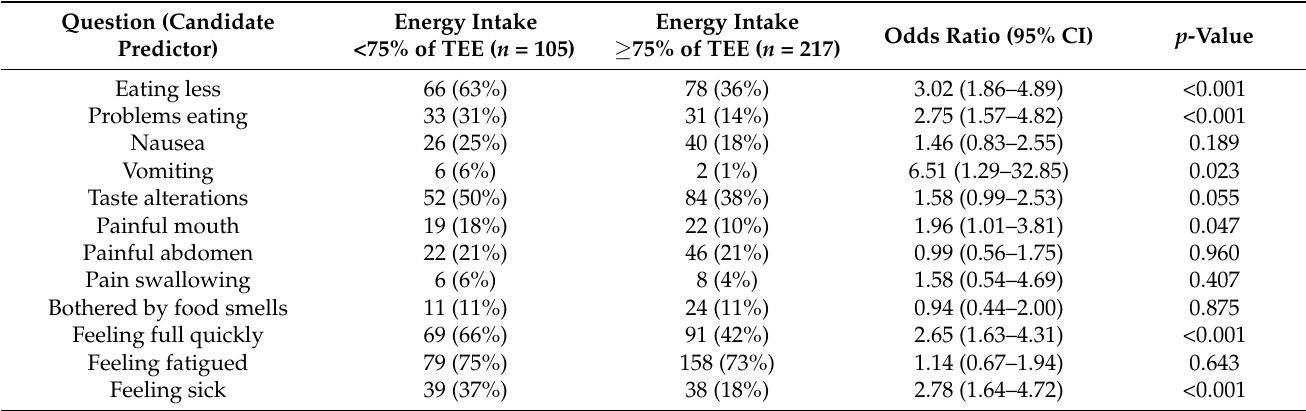
Table 3. Associations between each candidate predictor and energy intake <75% of Total Energy Expenditure (TEE) ( n = 322).